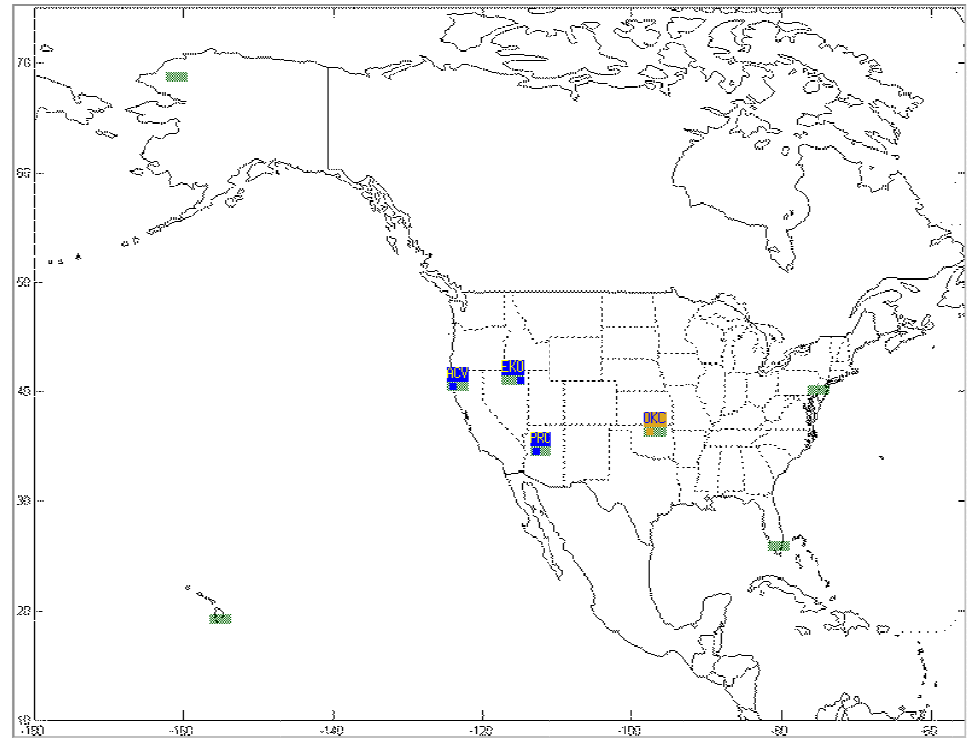
e 15. (a) T The position using NSTB data directi STB